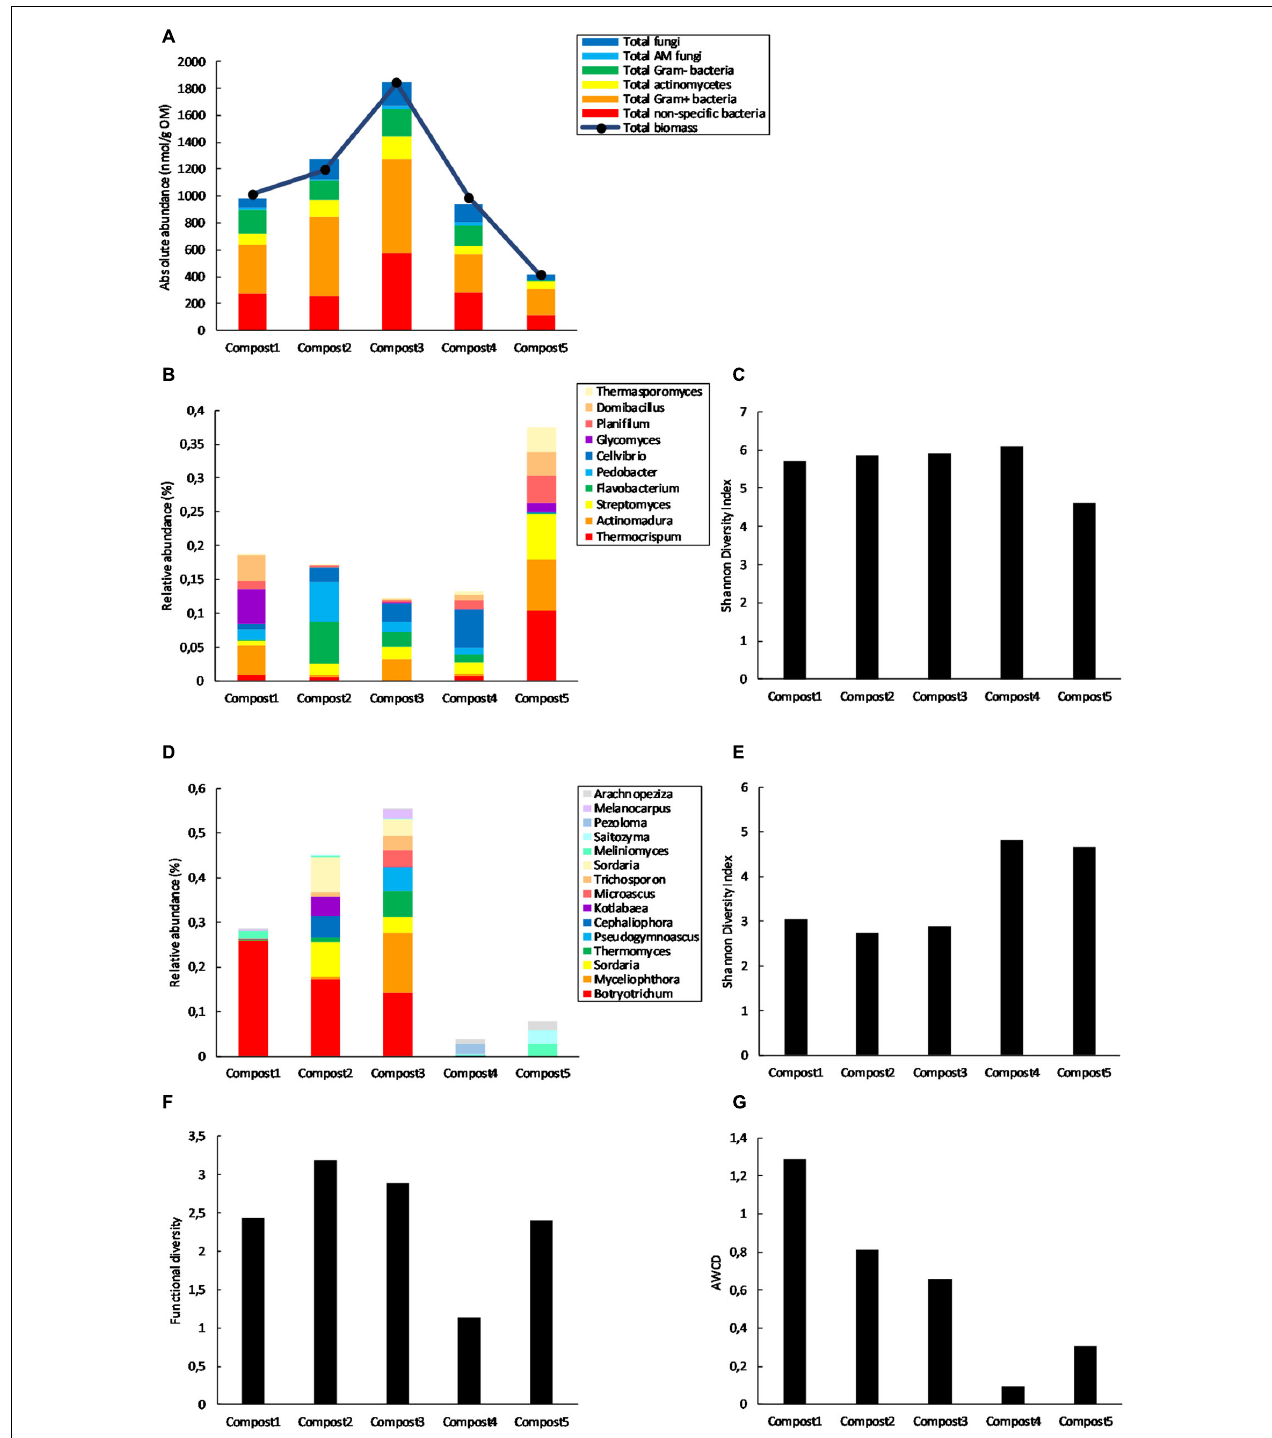
FIGURE 2 | Main biological differences between the five mature composts ( n = 1). (A) Absolute concentrations (nmol g − 1 organic matter) of PLFA biomarkers specific for different microbial groups and total microbial biomass (nmol g − 1 organic matter) in the five mature composts. (B) Relative abundance (percentages) of the 10 most abundant bacterial genera (16S V3-V4 region rRNA gene) in the five mature composts. (C) Bacterial diversity expressed as the Shannon Diversity Index in the five mature composts and calculated from the metabarcoding data. (D) Relative abundances (percentages) of the 15 most abundant fungal genera (ITS2 gene) in the five mature composts. (E) Fungal diversity expressed as the Shannon Diversity Index in the five mature composts and calculated from the metabarcoding data. (F) Functional diversity (calculated as the Shannon Diversity Index) of the five mature composts calculated from the Biolog data. (G) Microbial activity expressed as the average well color development (AWCD) of the five mature composts and calculated from the Biolog data.